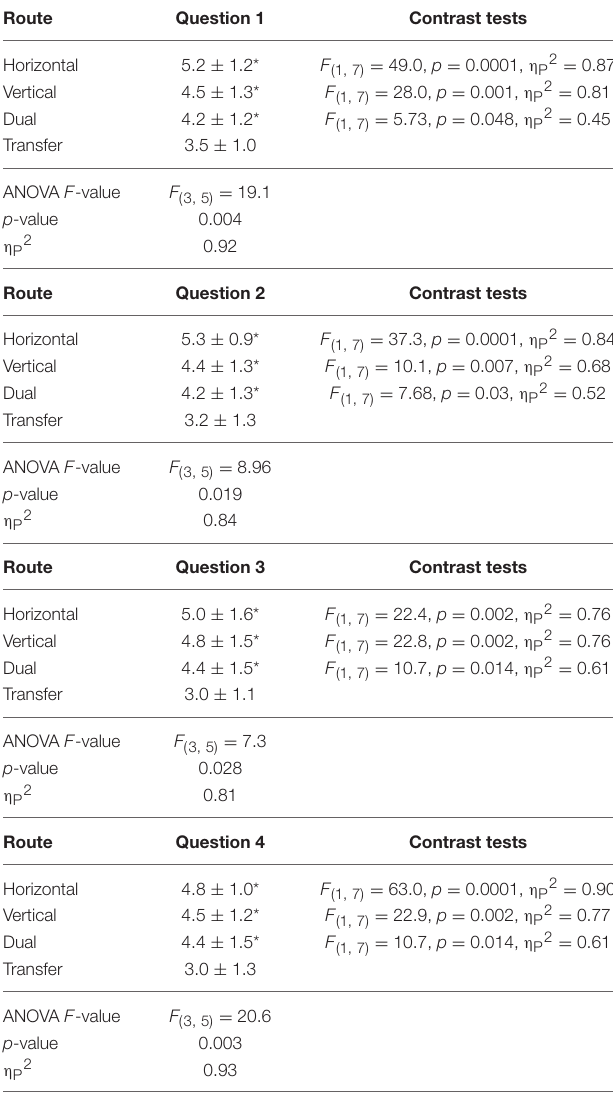
TABLE 4 | Differences between the transfer test and the three routes performed during the learning protocol concerning the perception of the route approach.